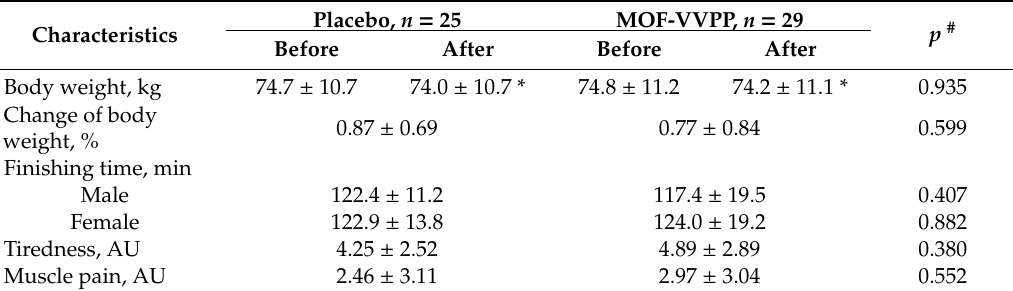
Table 3. Clinical and performance characteristics in recreational runners before and after the use of a 400-mg single dose of ibuprofen followed by the completion of the half-marathon.